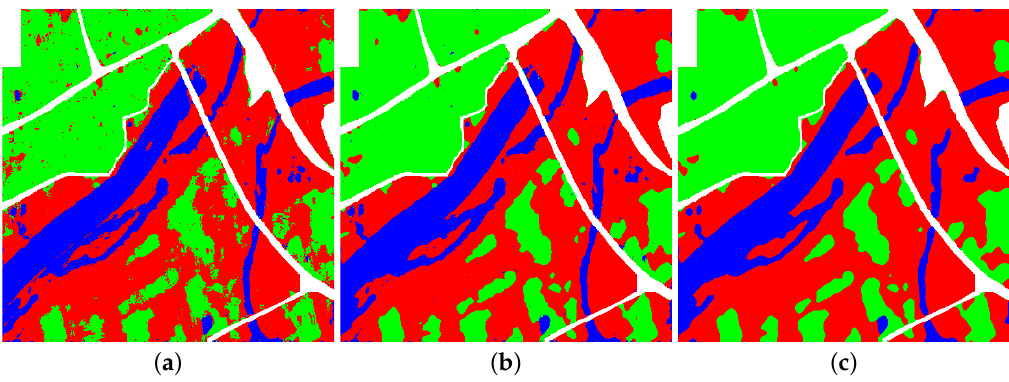
Figure 8. Classification result corresponding to the ground-truth of Xi’an area image obtained by each step of the proposed method, including: ( a ) classification network based on the proposed MAE; ( b ) post processing with SF filter; and ( c ) further post processing with MS